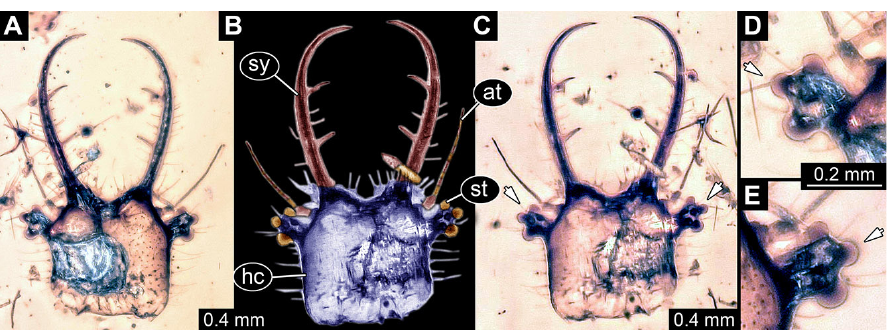
Figure 35. Fossil owllion larva, specimen 3248 (PED 1206), Cretaceous Kachin amber, Myanmar. ( A ) Overview, one side. ( B ) Color-marked version of ( C ). ( C ) Overview, other side. ( D , E ) Close-ups on fields of stemmata (arrows). Abbreviations: at = antenna; hc = head capsule; st = stemmata; sy = stylet. 38. Specimen 3249 (Weiterschan BuB 23), preserved in Cretaceous Kachin amber, Myan- mar. Specimen is well accessible in ventral view (Figure 36A,B), largely concealed in dorsal view (Figure 36C). Head capsule roughly square-shaped in dorsal view, slightly wider than long; stylets longer than head capsule (Figure 36A–C). Stemmata on prominent protrusions on each side of head capsule (Figure 36D). Antennae small, very slender, far lateral, slightly anterior to stemmata. Each stylet has two major teeth and few smaller teeth or robust setae (Figure 36A–C). No palps apparent. Mesothorax and metathorax with very prominent dorso-lateral protrusions bearing numerous se- tae (Figure 36A,B). Thorax segments ventrally with locomotory appendages. Legs distally with three prominent elements (femur, tibia, tarsus), with the tibia and tarsus well separated (Figure 36E). Anterior abdomen segments also with protrusions, but smaller ones. Trunk end about as long as wide in dorsal view, with numerous setae. Total length of specimen is 3.68 mm.